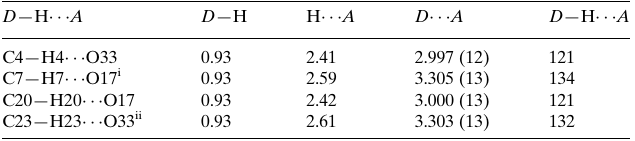
Hydrogen-bond geometry (A˚ , (cid:2)